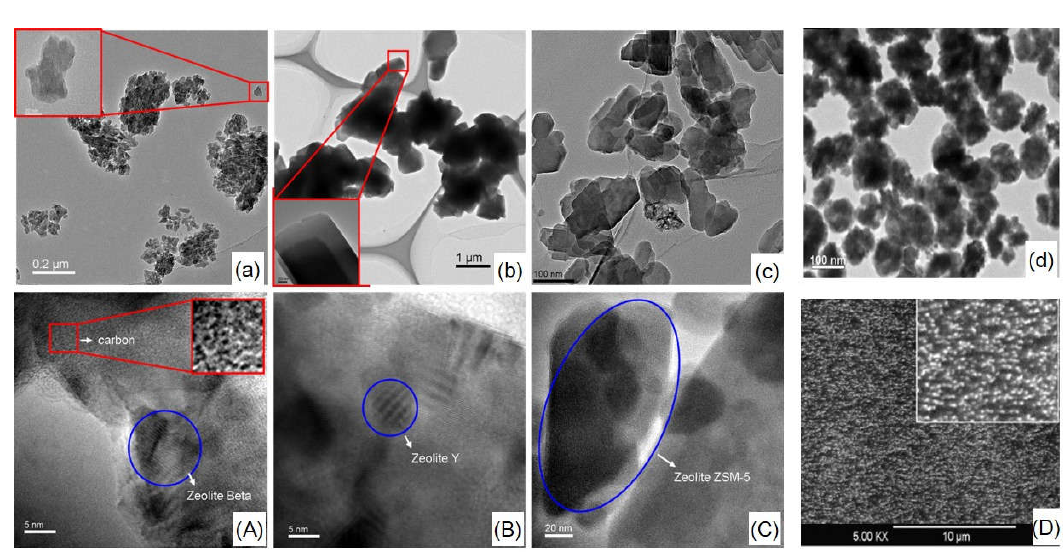
Figure 10. HRTEM and SEM images of zeolites: β ( a ), Y ( b ), ZSM-5 ( c ) [59] and zeolite L [54] ( d ) and related hybrid CMS membranes: β/C ( A ), Y/C ( B ), ZSM-5/C ( C ) [59] and zeolite L/C [54] ( D ).